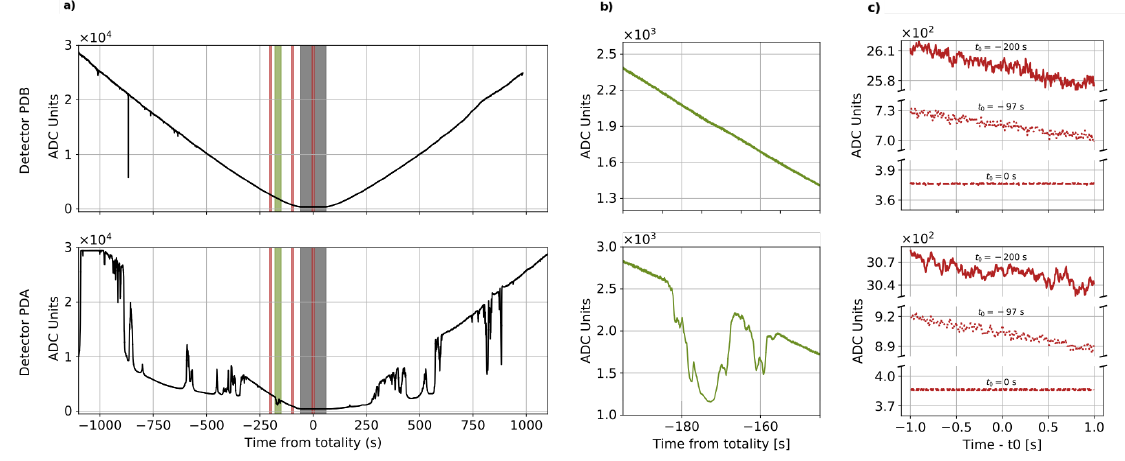
Figure 1: Time series of the photodiodes signals. (a) Whole time series of the balloon photodiode PDB (top), and a ground photodiode PDA (bottom). In grey shade, the totality of the eclipse. (b) Zoom of one of the moments when a cloud passed above the ground photodiodes, highlighted in green in the main plot. (c) Three zooms of three different moments of each signal, highlighted in red in the main